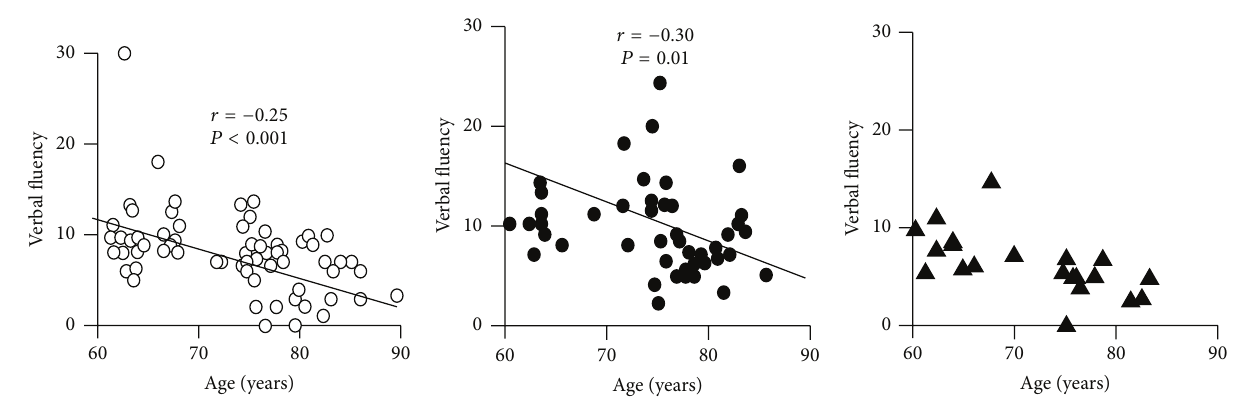
Figure 3: Regression of age with the memory tests in 220 subjects from general population.